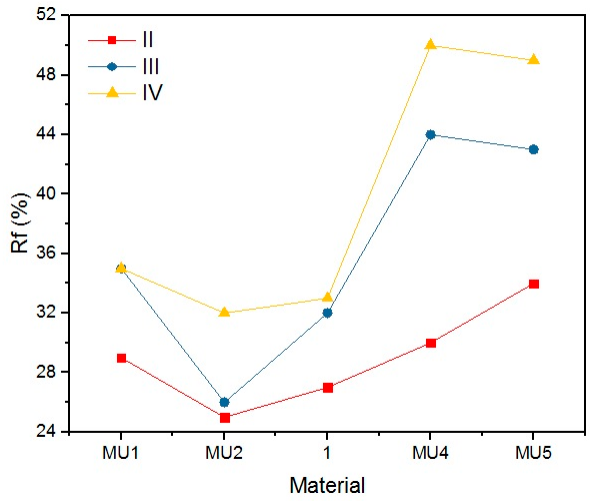
Figure 24. Shape retention rate after the rest period (T l = 4 °C) for materials programmed at different temperatures (II, 60 °C; III, 80 °C; and IV, 90 °C).